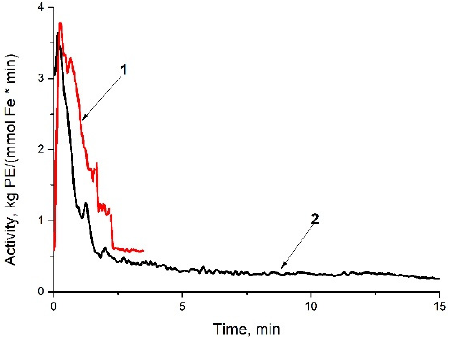
Figure 1. Kinetic curves of ethylene polymerization for exps. 1 and 2 in Table of Figure 2.